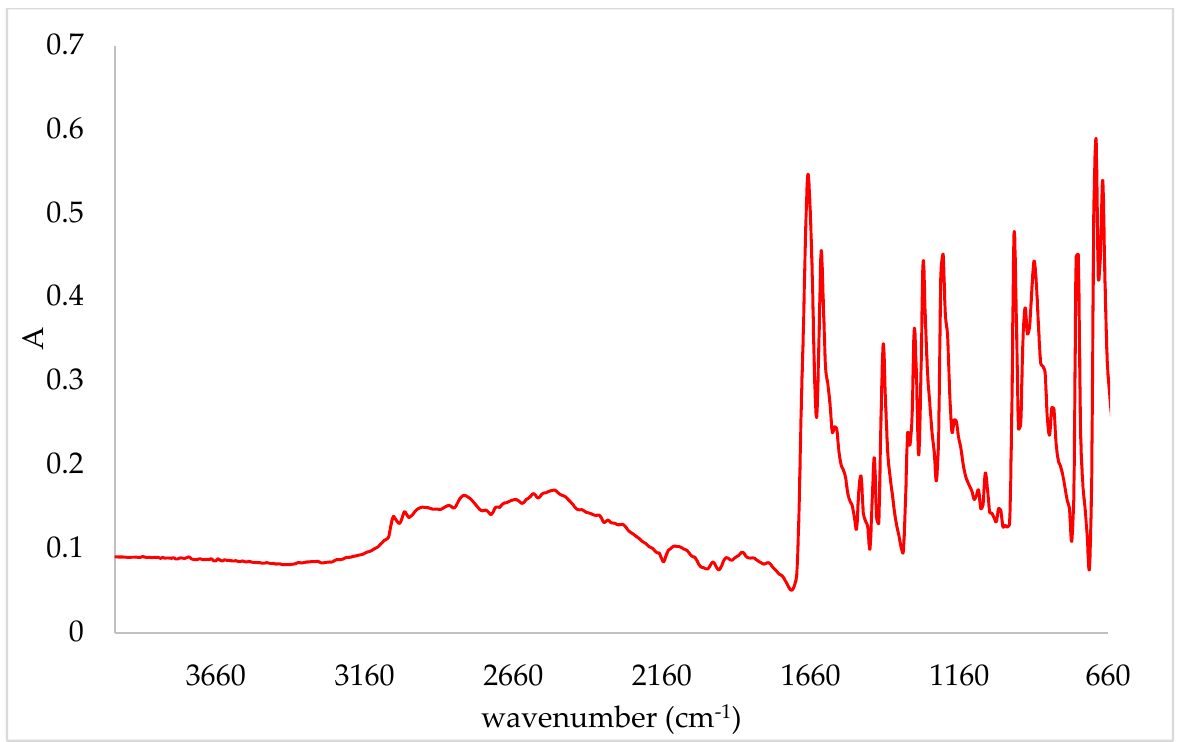
Figure 4. IR spectra of cinnamic acid.